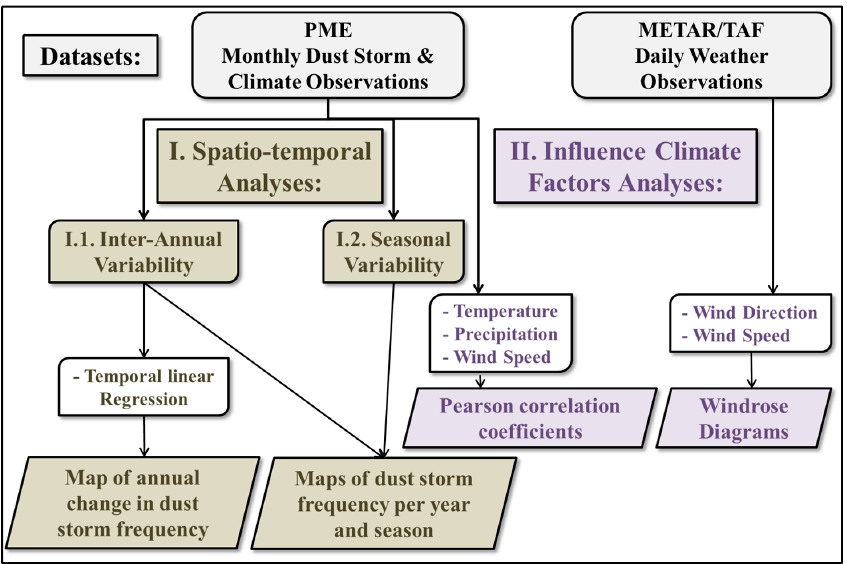
Figure 2. Methodological flowchart of spatio-temporal variability in dust storms over Saudi Arabia.